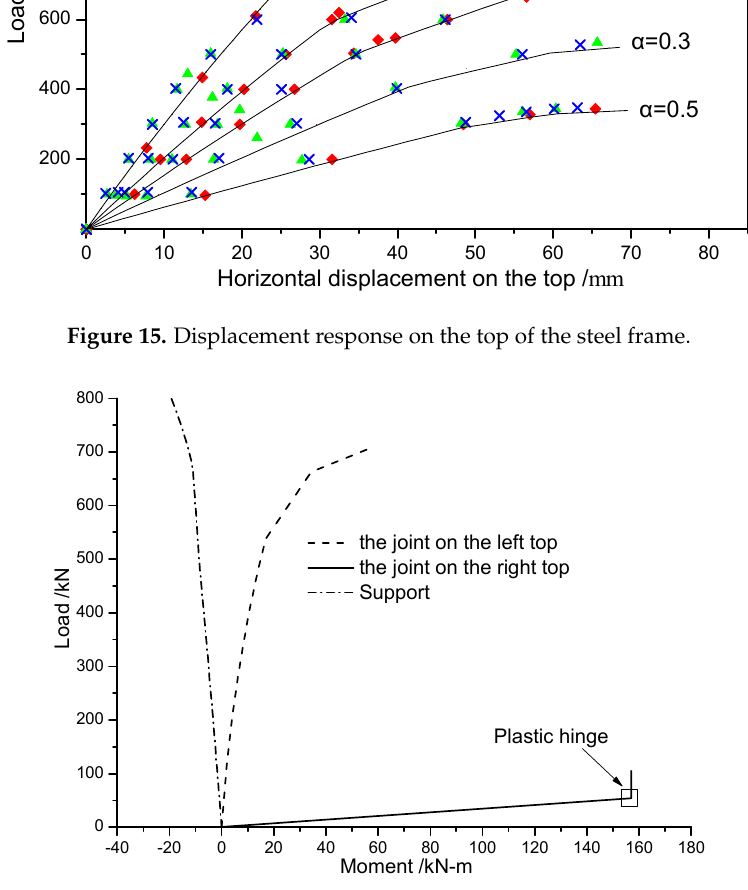
Figure 16. Load-moment curves of joints and supports.